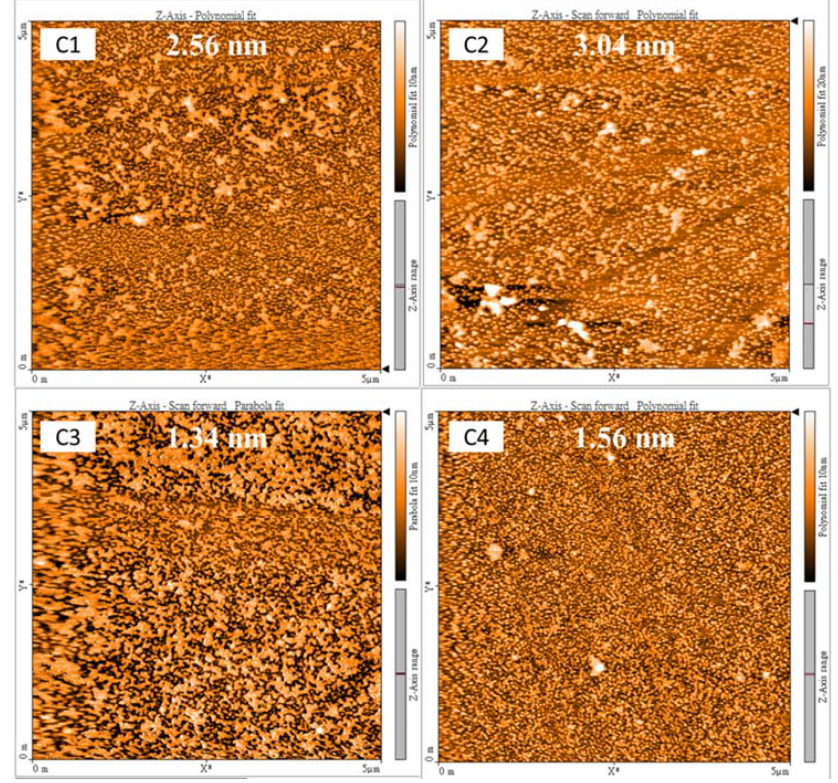
Figure 3. Atomic force microscopy (AFM) images and average roughness of four samples: C1, C2, C3, and C4.